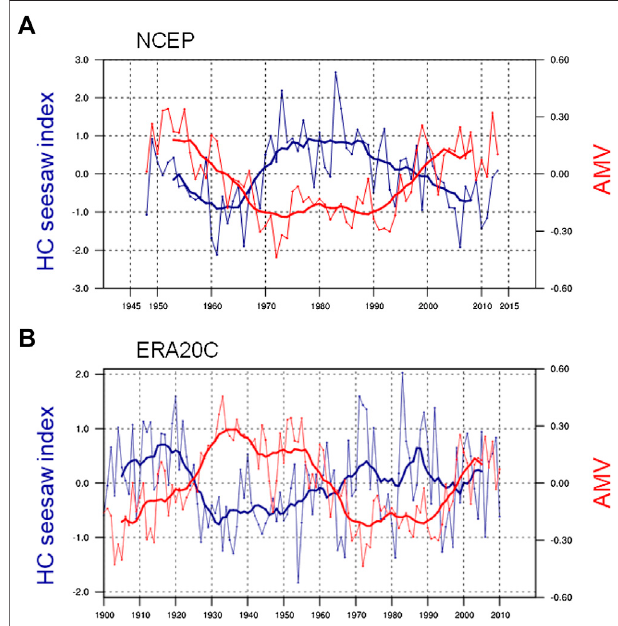
FIGURE 2 | (A) Time series of the normalized HC seesaw index (NH minus SH; blue lines) and AMV index (K) (red lines) for 1948 – 2013. The raw data (thin lines) and the decadal component (thick lines) are derived from the NCEP data set. (B) Same as in (A) , but for 1900 – 2010 based on the ERA20C data